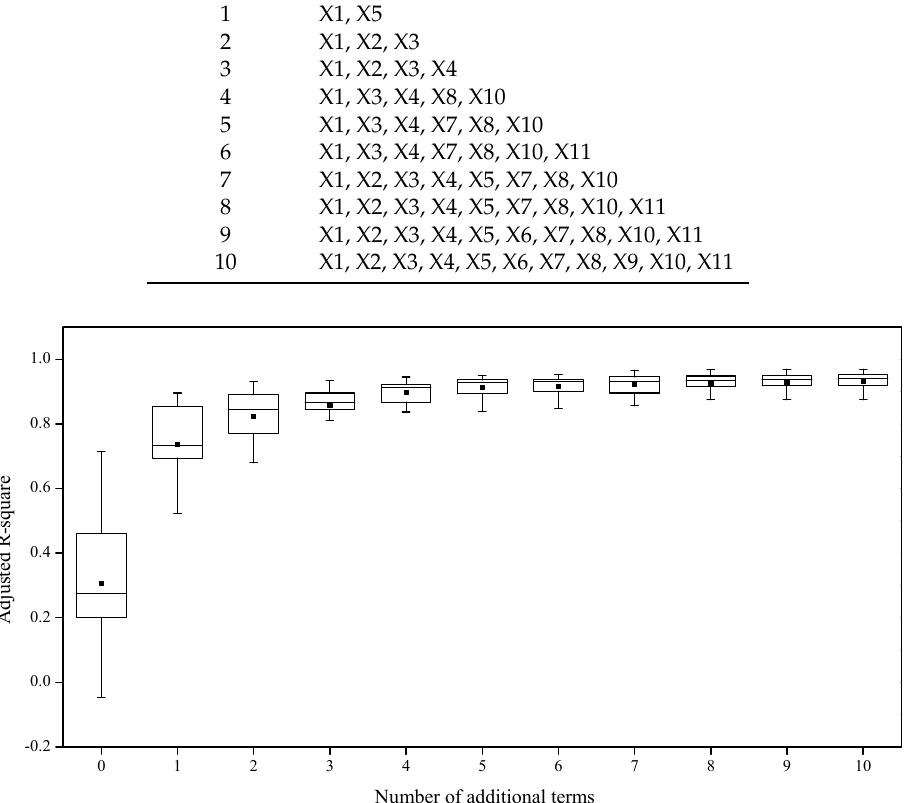
Figure 7. Box plots of adjusted R-square with different numbers of additional terms.